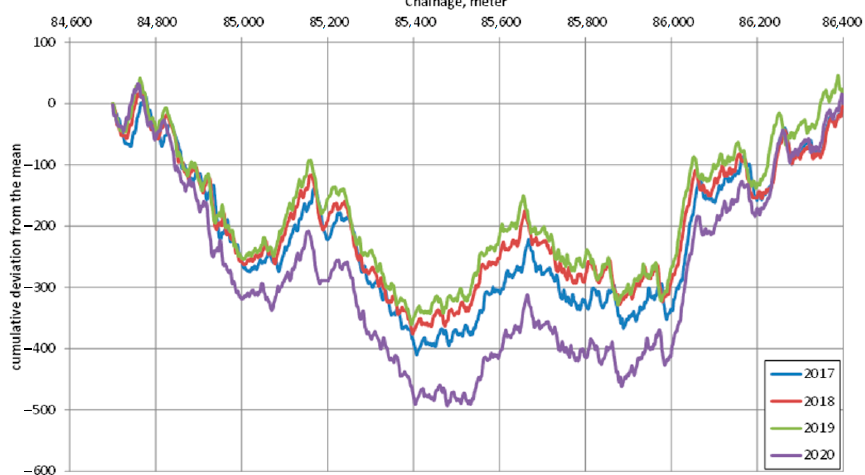
Figure 3. Cumulative deviation from the mean (section No. 1).